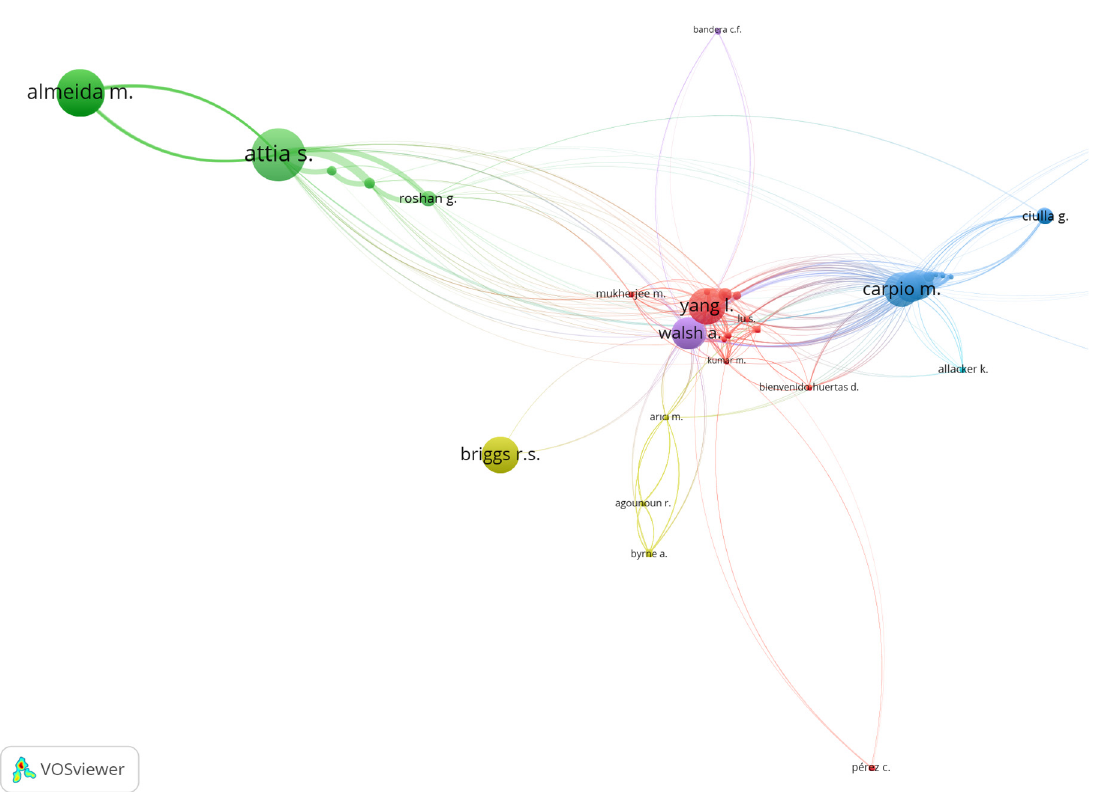
Figure 18. Bibliographic coupling network of authors.